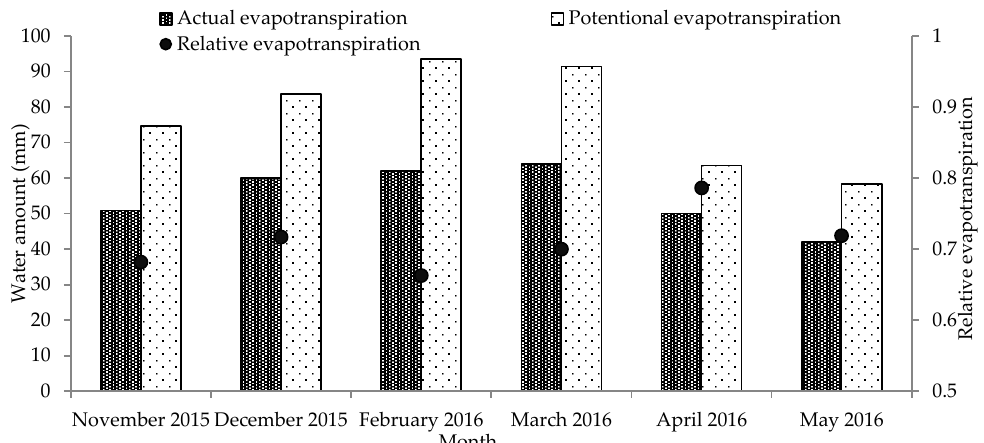
Figure 8. Actual, potential, and relative evapotranspiration of the study area during the winter season (from November 2015 to May 2016).